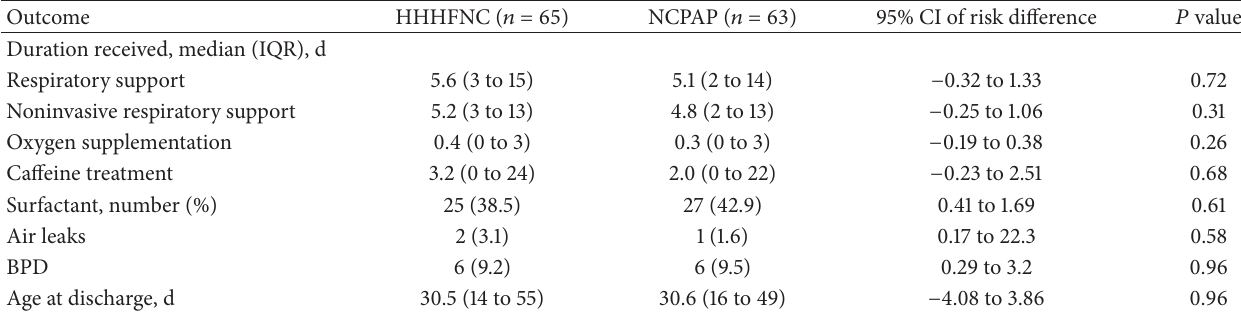
Table 3: Respiratory support outcomes among infants assigned to HHHFNC compared with NCPAP.